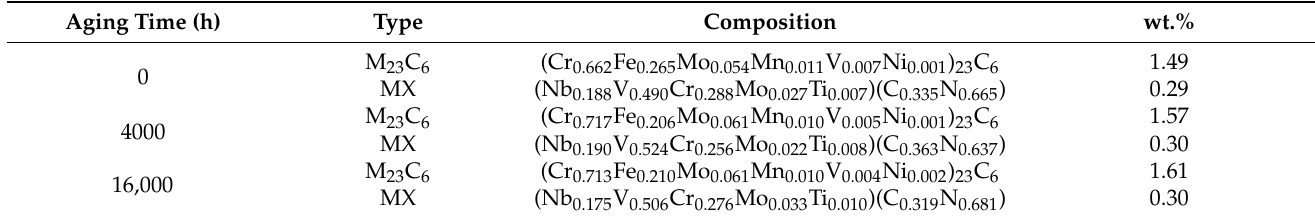
Table 2. Type, composition, and weight percentage (wt.%) of the precipitations in aged P91 steels.